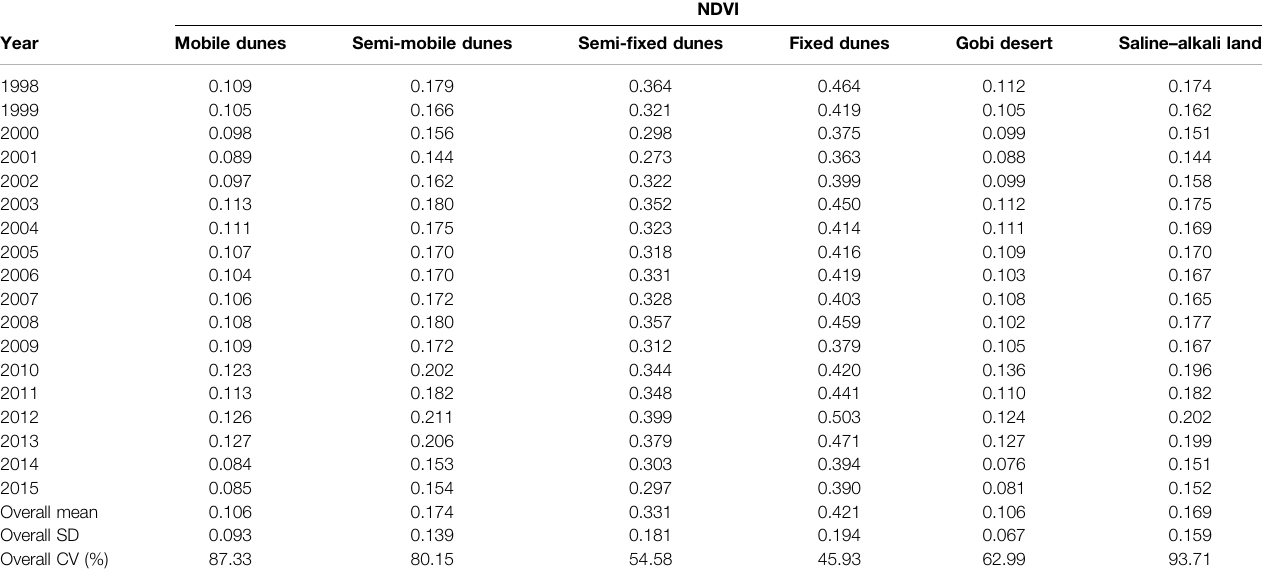
TABLE 1 | Changes intheannualmeannormalized-difference vegetation index (NDVI) for different desert types from 1998to2015in China, and statistical measures oftheir variation.